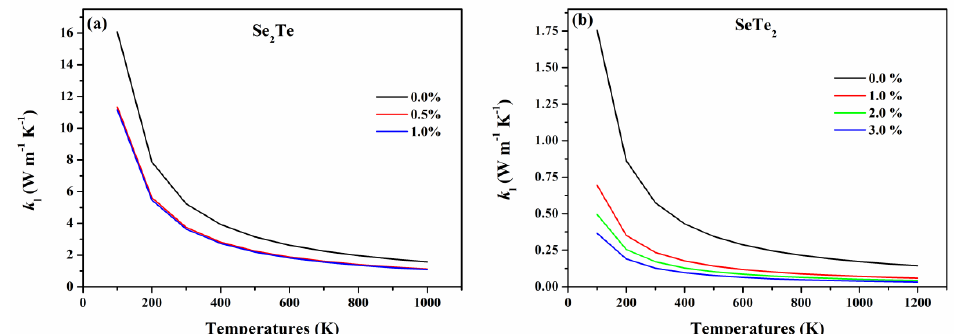
Figure 7. Strain-dependent lattice thermal conductivity k l of ( a ) Se 2 Te and ( b ) SeTe 2 monolayers as a Figure 7. (Color online) Strain-dependent lattice thermal conductivity k l as a function of tempera- function of temperatures. tures. ( a ) Se2Te and ( b ) SeTe2 monolayers .